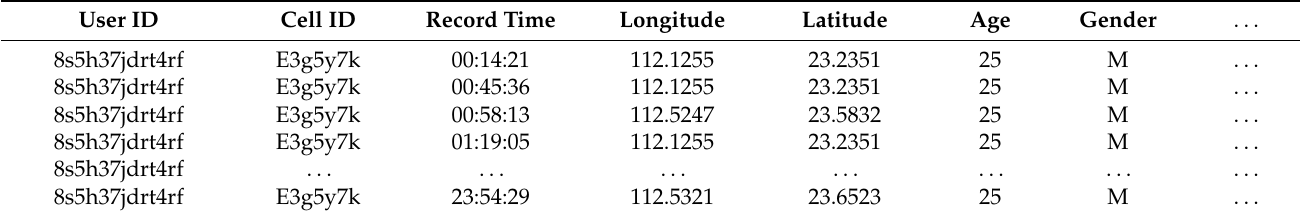
Table 2. Instance of an individual’s cellular signaling (CS) data records in a